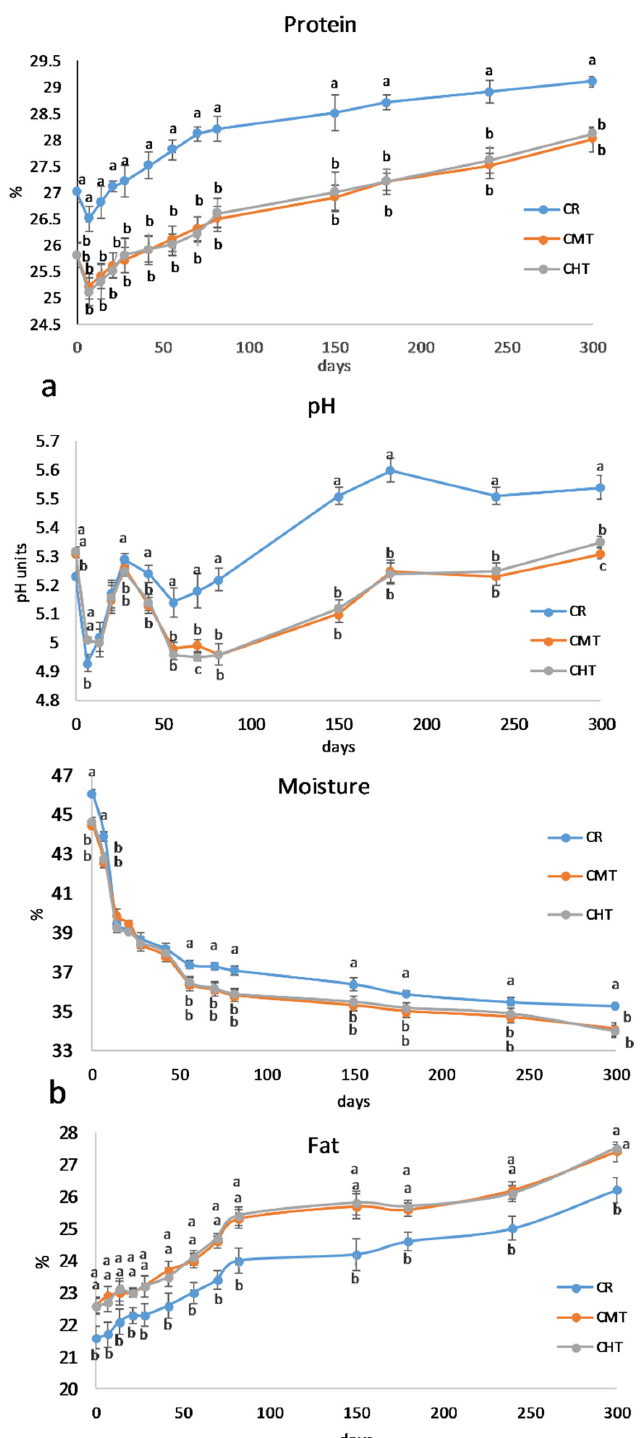
Figure 3. ( a ) Evolution of the moisture and fat contents in Canestrato Pugliese cheeses made from raw (CR), mild-thermized (CMT) and high-thermized (CHT) milk during ripening (0–300 days). Mean values of three analyses performed on two cheese wheels for each type of cheese. Different letters for the same ripening time indicate different values at p > 0.05; no letters means no difference. ( b ) Evolution of the protein content and pH in Canestrato Pugliese cheeses made from raw (CR), mild-thermized (CMT) and high-thermized (CHT) milk during ripening (0–300 days). Mean values of three analyses performed on two cheese wheels for each type of cheese. Different letters for the same ripening time indicate different values at p >